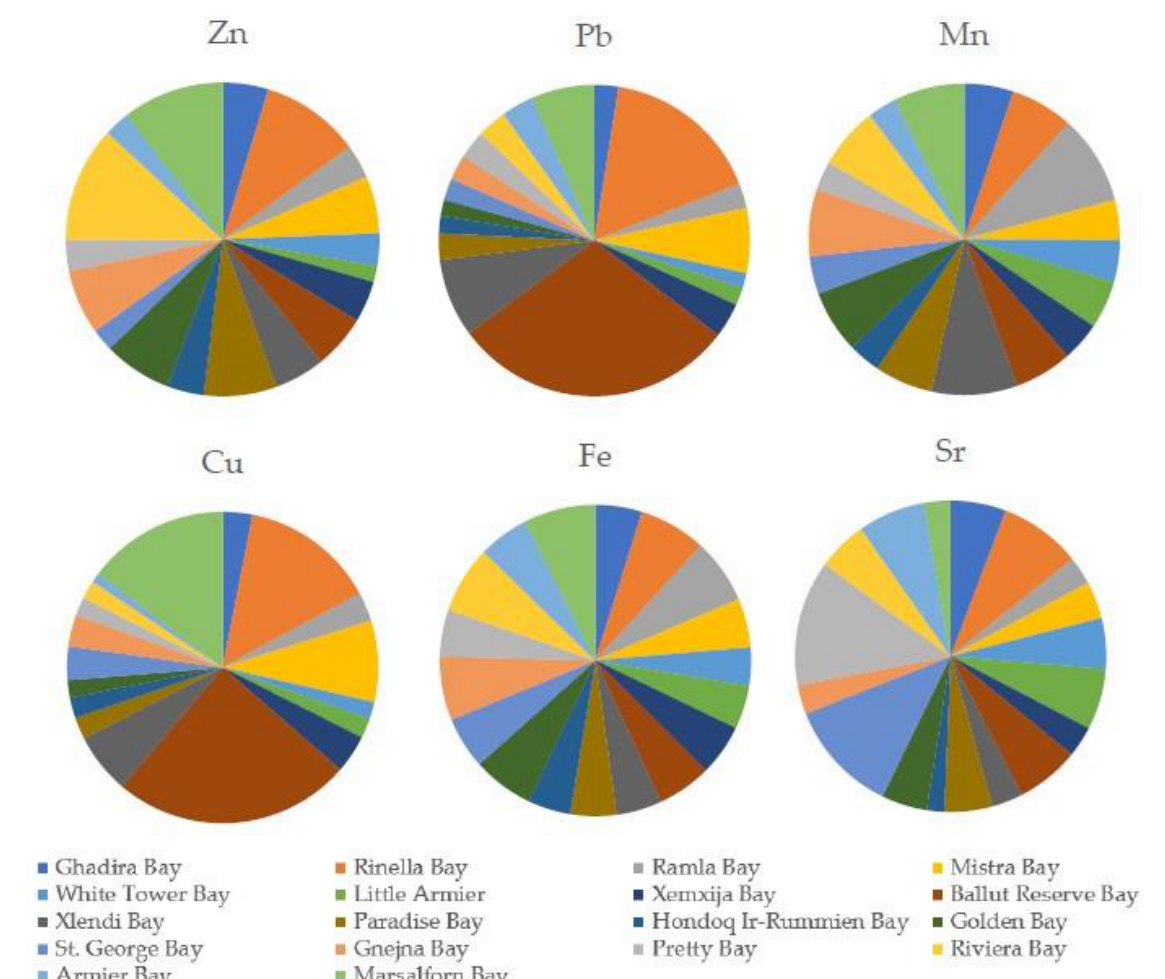
Figure 4. Pie charts illustrating the Hazard Index (HI) for children across bays reviewed in Malta and Gozo.